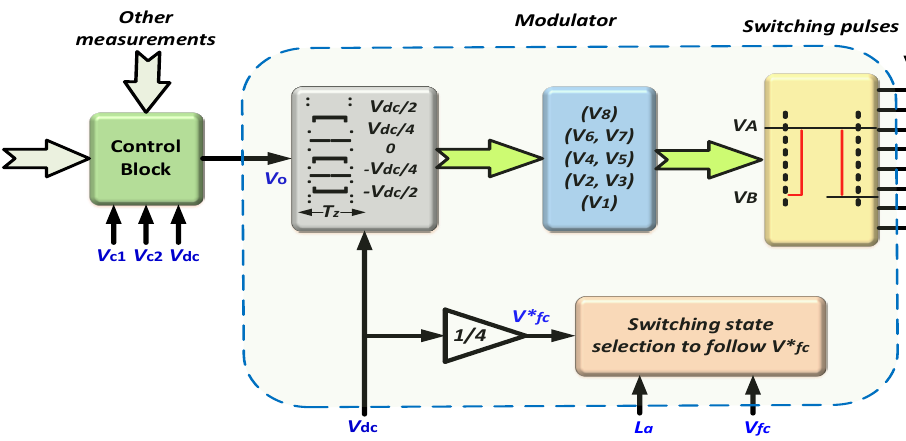
Figure 17. Conventional modulator [143].